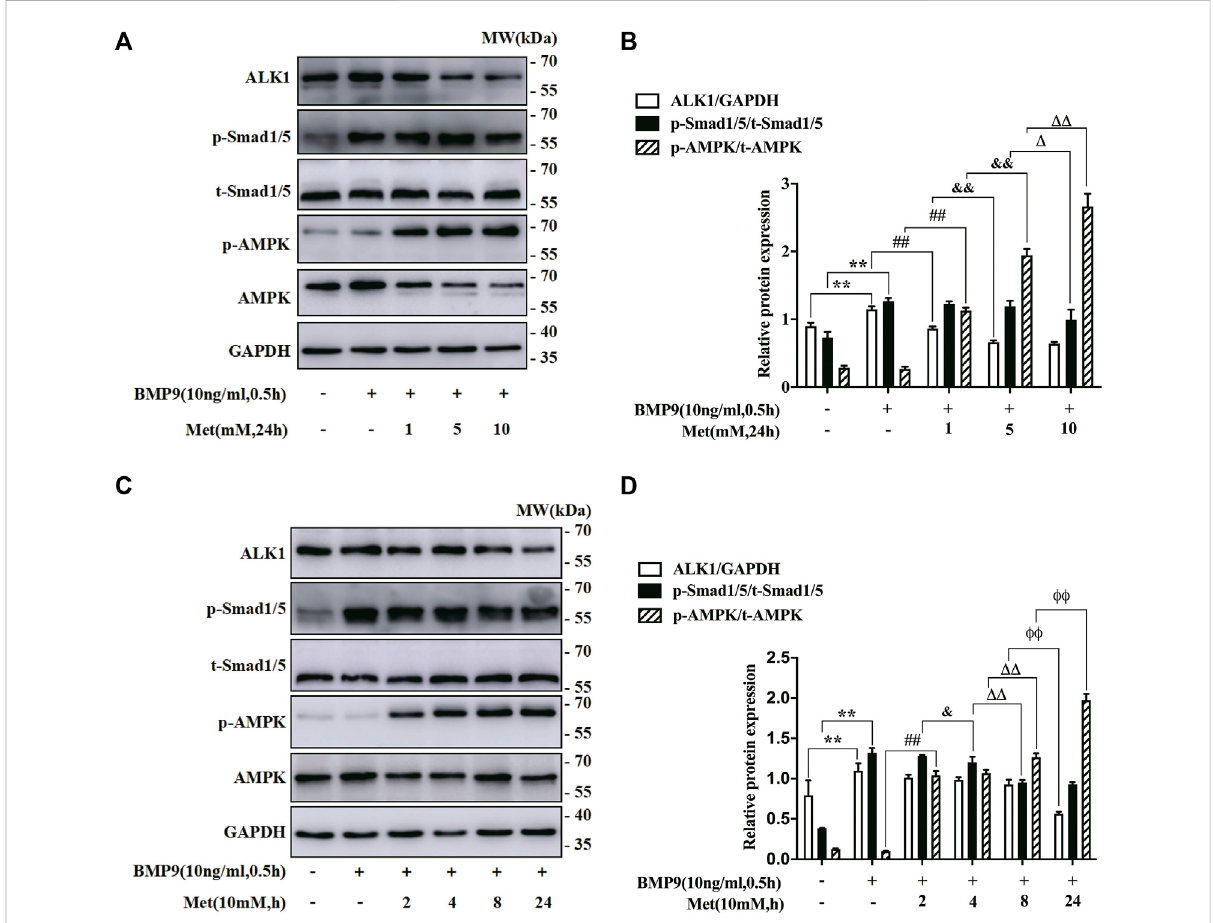
FIGURE 2 Role of metformin in the expression of BMP9 downstream signalling molecules and AMPK. (A,B) : Western blot was used to detect the expression of p-AMPK, ALK1 and p-Smad1/5 in HFL-1 cells with different concentrations of metformin (0, 1, 5, 10 mM) and 10 ng/ml BMP9 for 0.5 h ( n = 3). (C,D) : Western blot was applied to test the expression of p-AMPK, ALK1 and p-Smad1/5 in HFL-1 cells with 10 mM metformin for different times(2,4,8and24 h)and10 ng/mlBMP9for0.5 h.Cellsdealtwithculturemediumwereservedascontrolgroup( n